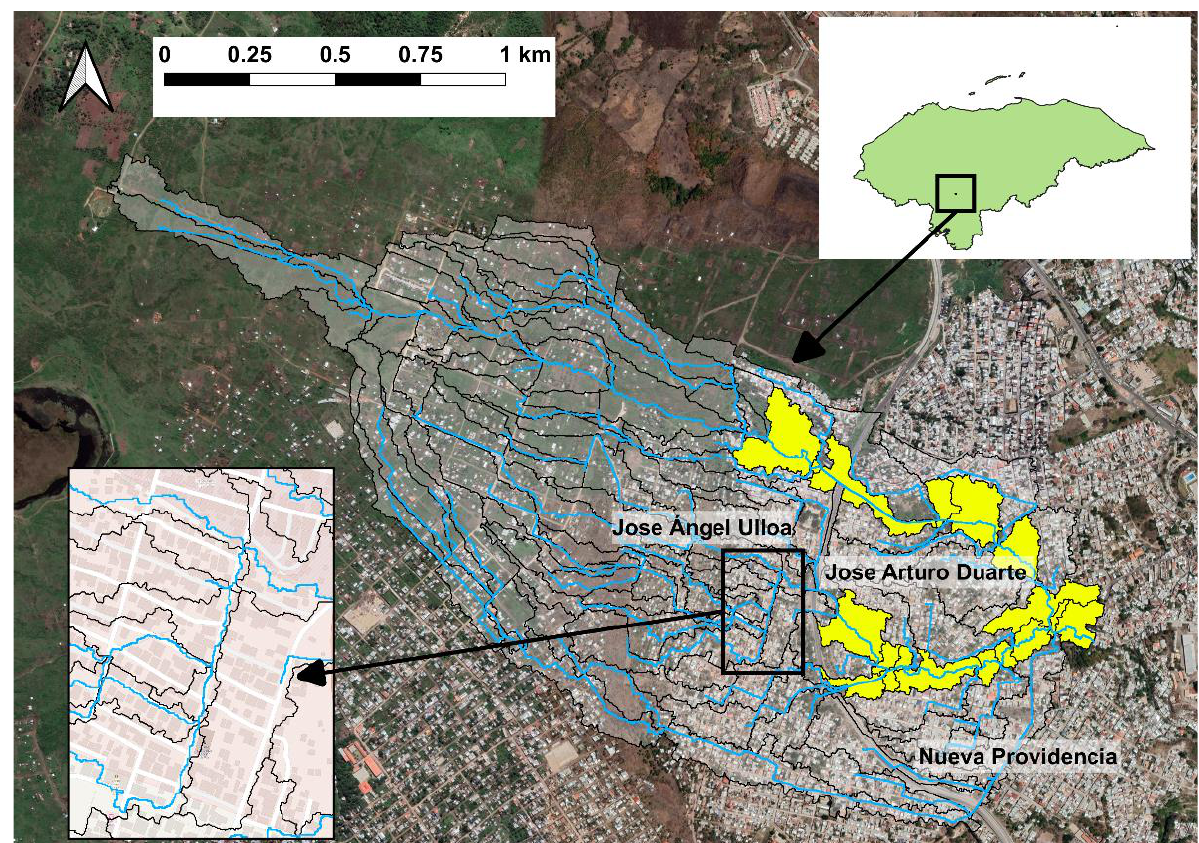
Figure 2. The delineated basins and the associated streams of the study area. The basins highlighted with yellow are those that contain the two main branches. The inset at the bottom left corner demonstrates the delineated streams that follow the path of the streets.